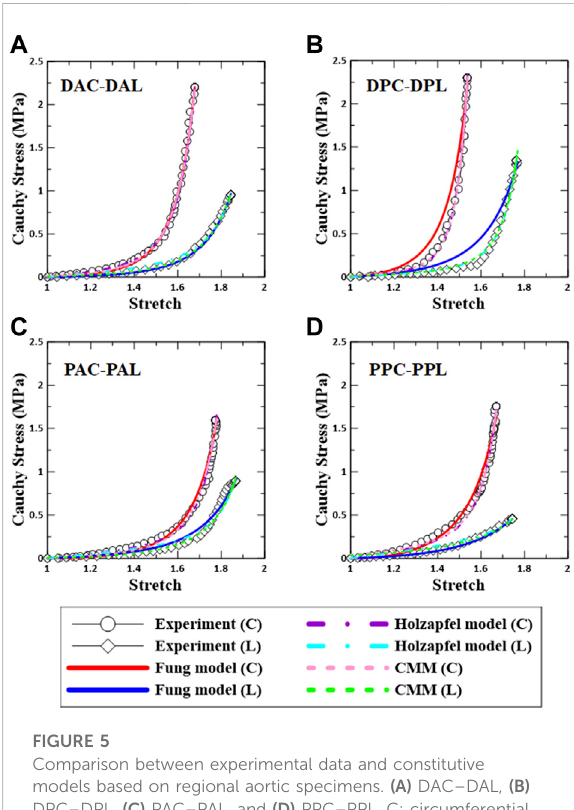
FIGURE 5 Comparison between experimental data and constitutive models based on regional aortic specimens. (A) DAC – DAL, (B) DPC – DPL, (C) PAC – PAL, and (D) PPC – PPL. C: circumferential specimen; L: longitudinal